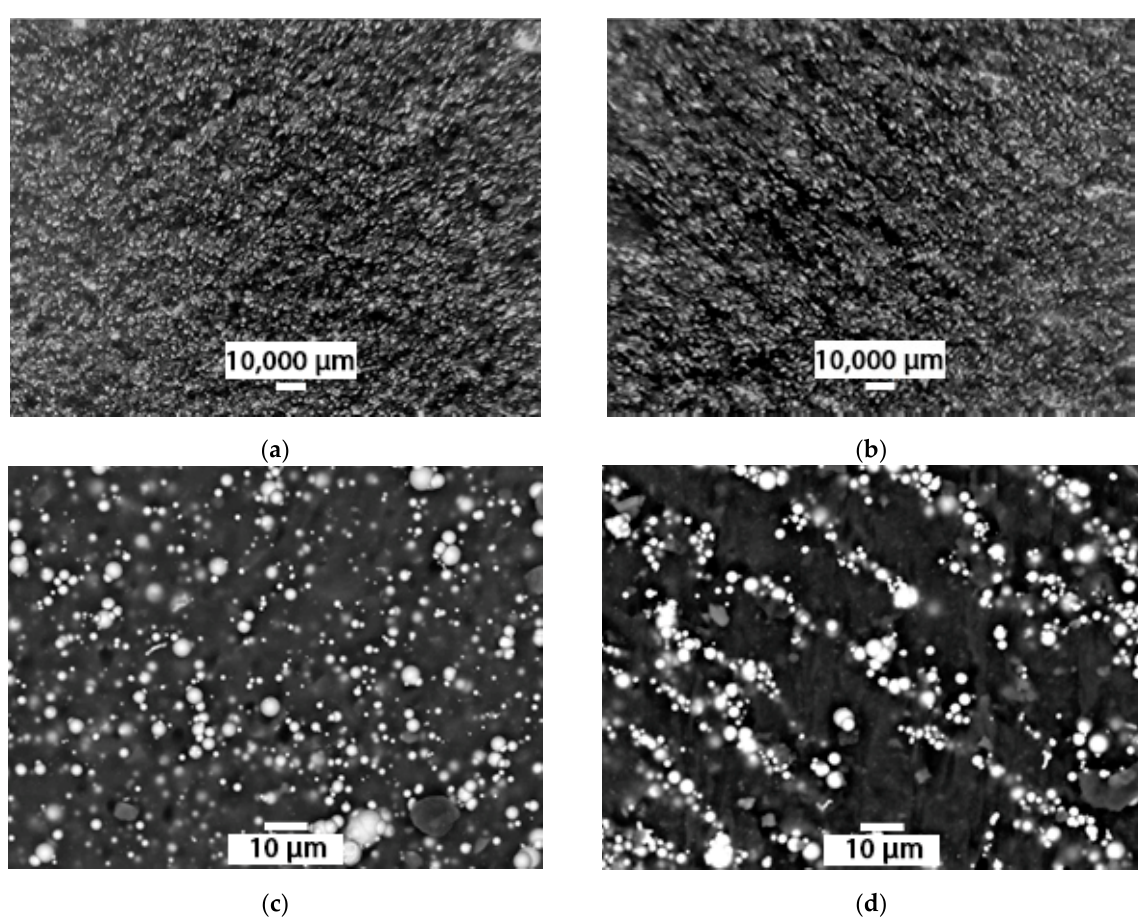
Figure 2. Filling agent particle distribution in the polymer matrix MAE*: Atomized powdered iron filler: ( a ) isotropic sample, ( b ) anisotropic sample; R-10 carbonyl iron filling agent: ( c )—isotropic sample, ( d ) anisotropic sample. *Due to the large difference in the filling agent particle sizes, different image scales have been chosen by way of illustration.